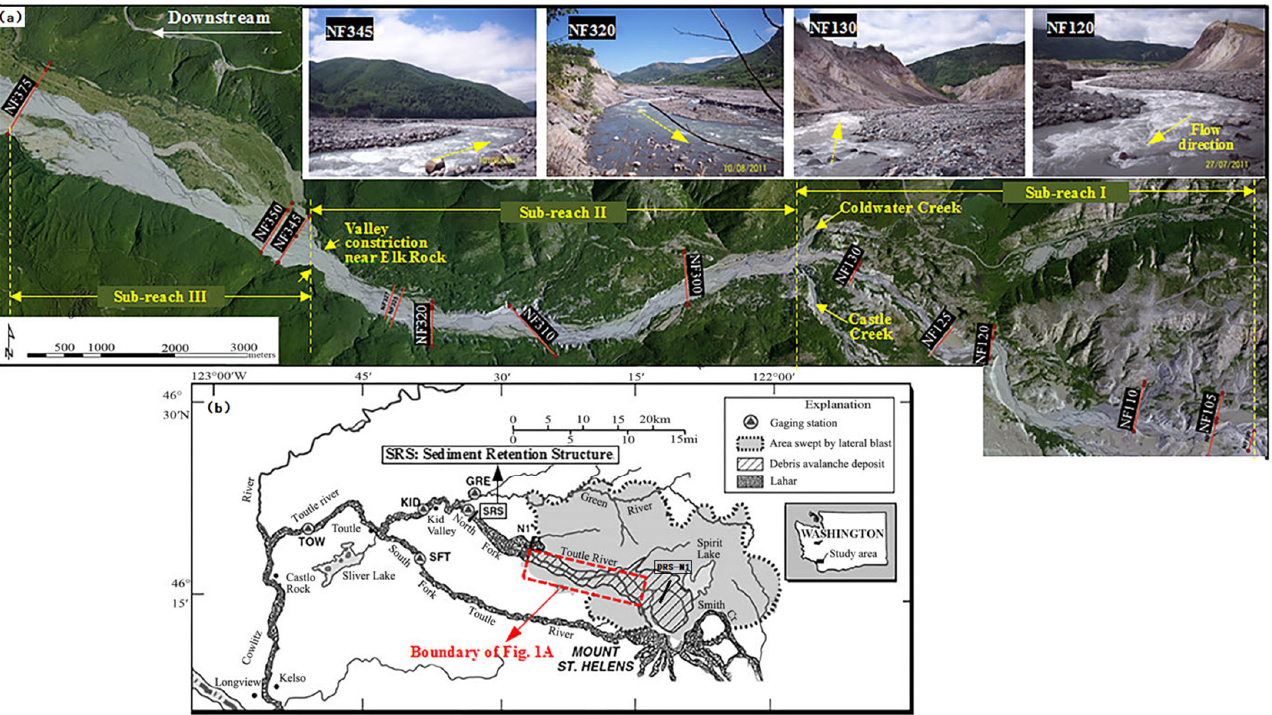
Figure 2. Study area: ( a ) study channel and cross sections and ( b ) Toutle River Basin [8]. Reprinted with permission from ref. [8]. Copyright 2021 John Wiley &